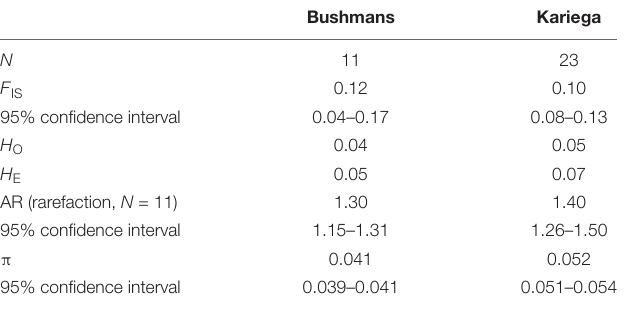
Bushmans Kariega